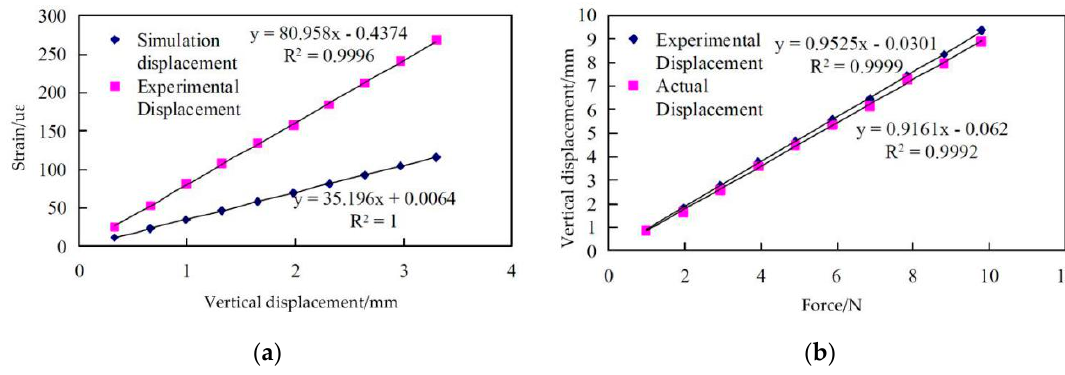
Figure 26. ( a ) Relationship between vertical displacement and strain at Point 1; ( b ) Comparison between actual displacement and experimental displacement at Point 1 [95].